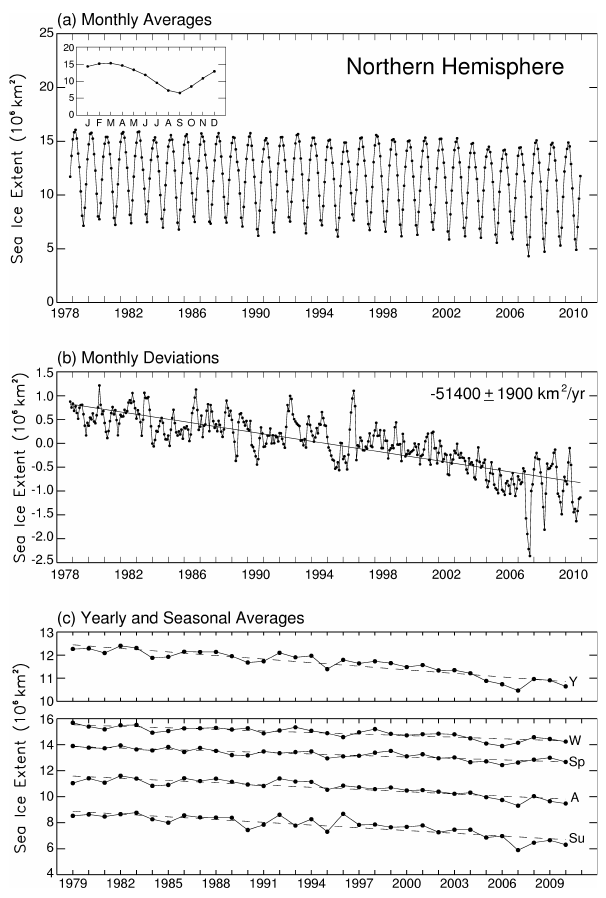
Fig. 2. (a) Monthly averaged Northern Hemisphere sea ice extents for November 1978 through December 2010. The inset shows the average annual cycle. (b) Monthly deviations for the sea ice ex- tents. (c) Yearly and seasonally averaged sea ice extents for the years 1979–2010. The winter (W), spring (Sp), summer (Su), and autumn (A) values cover the periods January–March, April–June, July–September, and October–December,